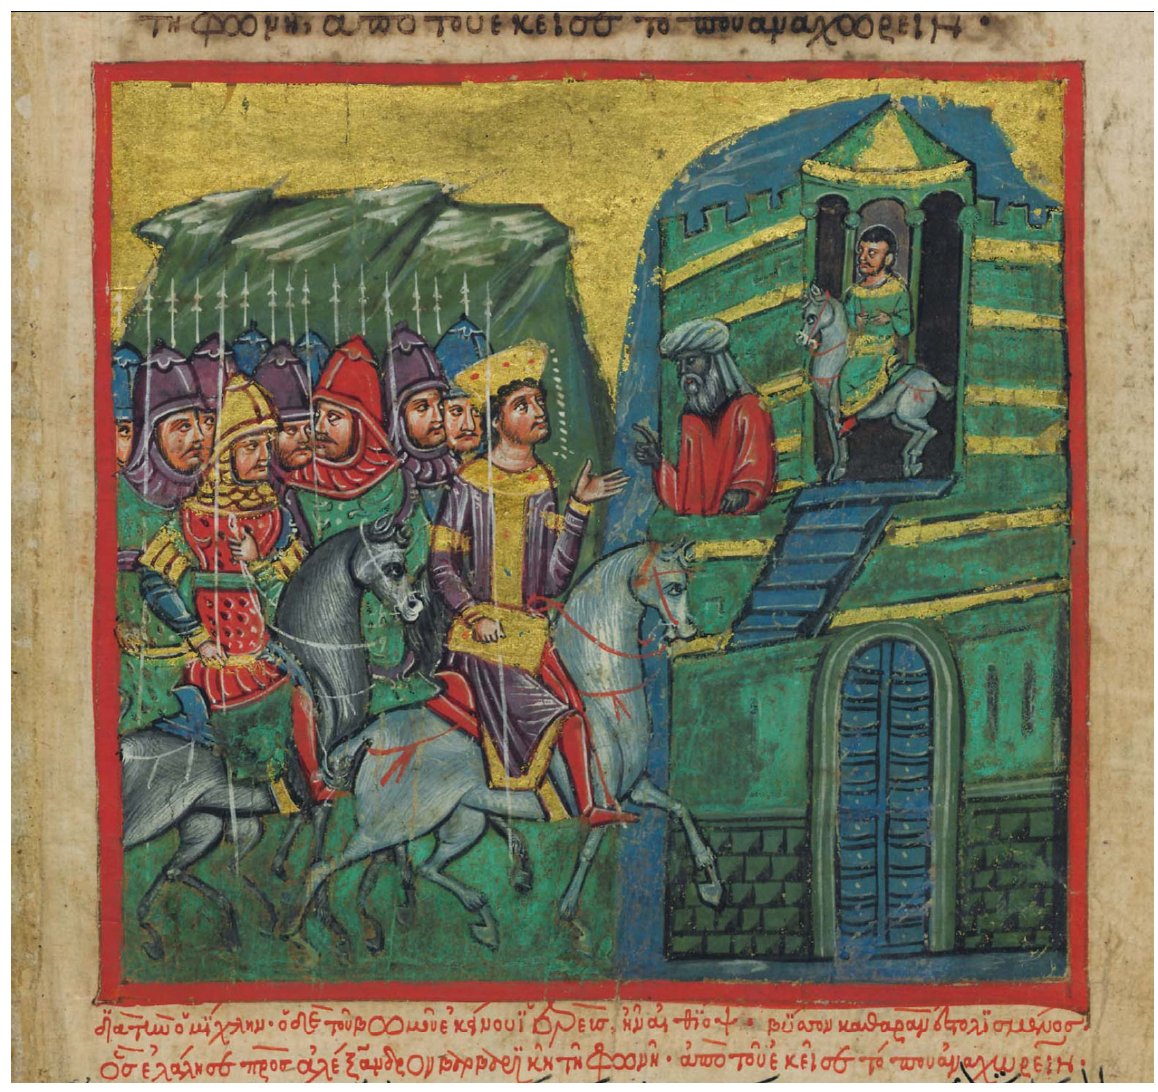
Figure 18. Venice. Istituto Ellenico di Studi Bizantini e Postbizantini cod. 5, fol. 183r (detail). Alexander’s encounter with an Ethiopian priest. Photo: ©Istituto Ellenico di Studi Bizantini e Postbizantini, Venice, all rights